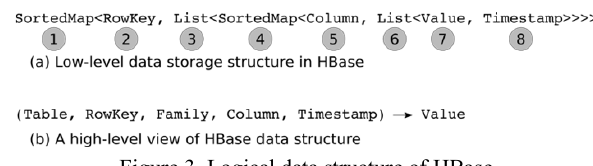
Figure 3. Logical data structure of